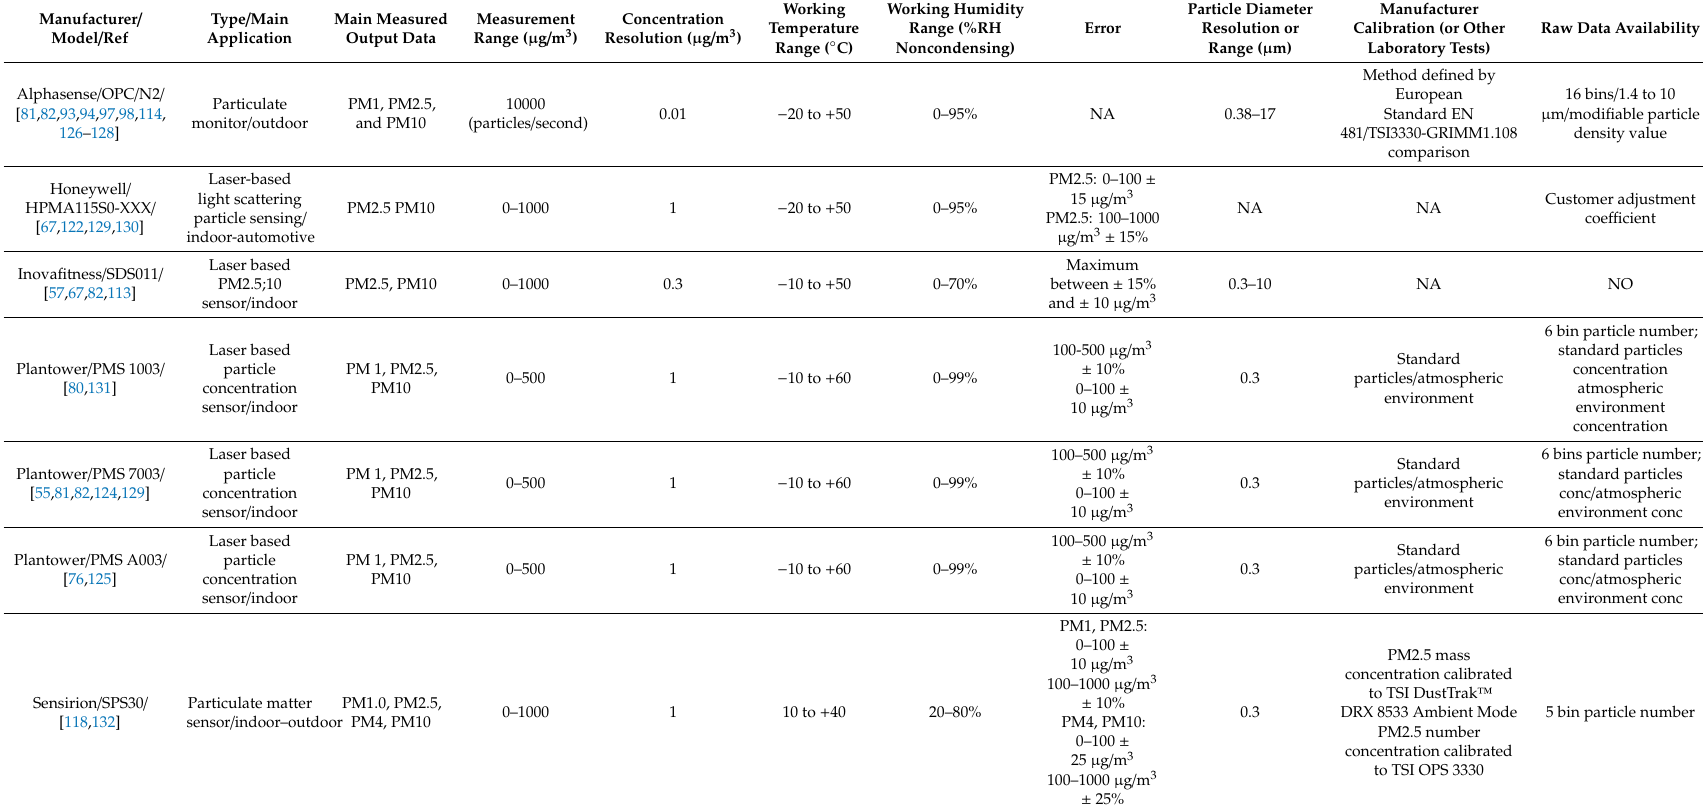
Table 5. Metrological characteristics, obtained from the o ffi cial manufacturers’ websites and freely available technical sheets. The first column refers to the manufacturer’s name, the device model, and the papers and refers to applications based on that sensor model. Column two reports the device’s basic operating mechanism and its main application scenario. Column three reports the device output in µ g / m 3 or pcs / L. Columns four, five, and six report, respectively, the measurement range and its resolution in units corresponding to the device output, as well as the indication error related to the device output. Columns seven and eight are, respectively, the sensor operating temperature range and the RH operating range, respectively. Column nine reports the minimum detectable value of the particle size for each of the sensors discussed. Column 10 reports information on device calibration and the way it was performed. In column 11, the possibility to access raw data is